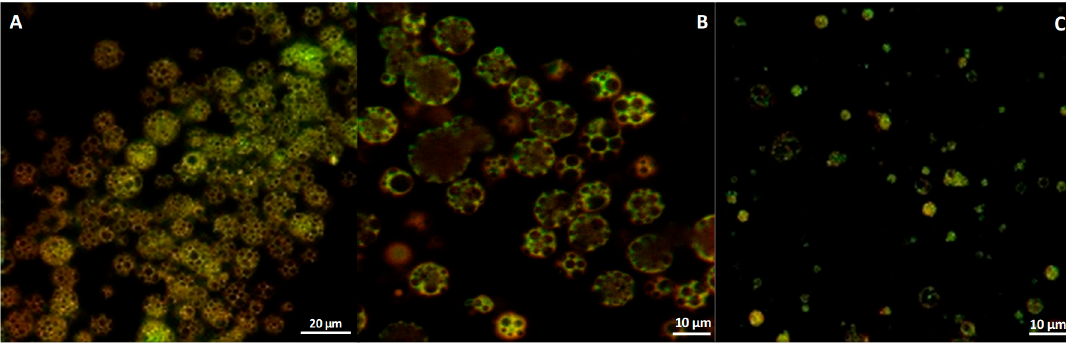
Figure 1. Confocal images of curcumin-loaded microparticles: ( A ) curcumin (CUR)–oil, ( B ) CUR–water and ( C ) CUR–nano-emulsion (NE).